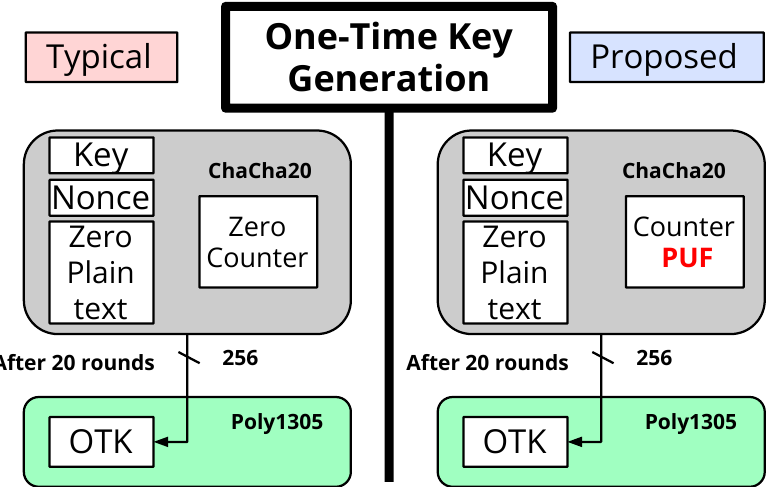
Figure 4. Block diagram of one-time key